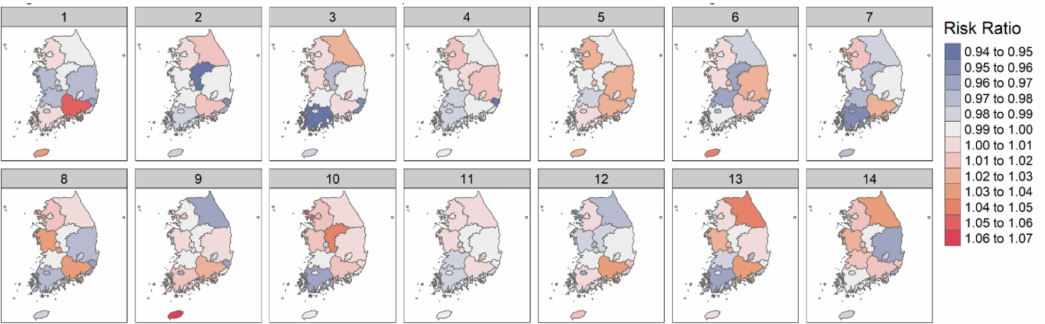
Figure 1. Association between DTR and amputation of diabetic foot in each region.